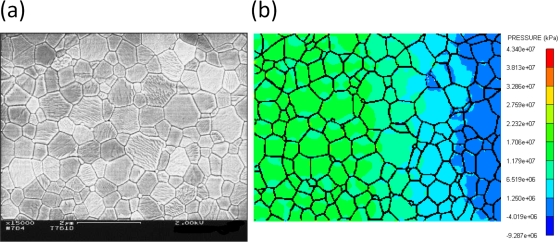
(a) Micrograph of a HPC (Al2O3) exhibiting the micro structure with an average grain size of 0.7 μm. (b) 2D FEM simulation of a primitive model of this micro structure with a shock impulse traveling through the material from left to right. The plane of the micrograph has been sectioned into 601 × 442 equal-spaced squares which are used as finite elements. The nodes of the upper and lower edge have been assigned
υ→=0 as boundary condition, whereas the leftmost element nodes of the sample are given an initial speed of vx = 500 m/s. The color code exhibits the pressure profile.